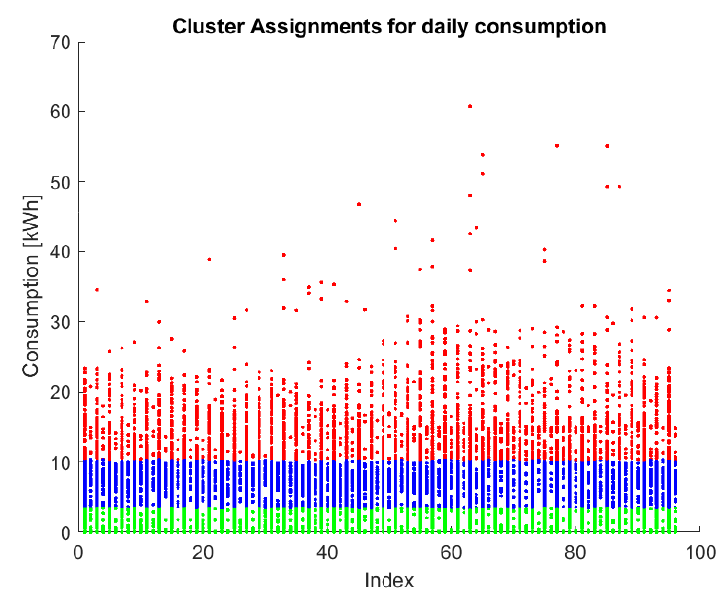
Figure 7. Representation of the 3 clusters in which the daily consumption data, recorded every 15 min from the swimming complex, was grouped. Green—the cluster of the high-value consumption data, red—the cluster of the medium-value consumption data, and blue—the cluster of the low-value consumption